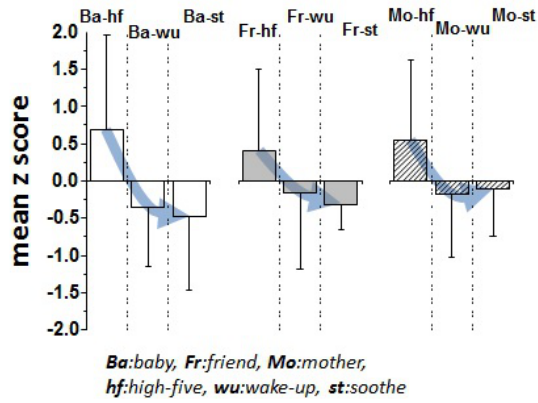
Fig. 8. The time average of contact force in the experiment with non- autistic children